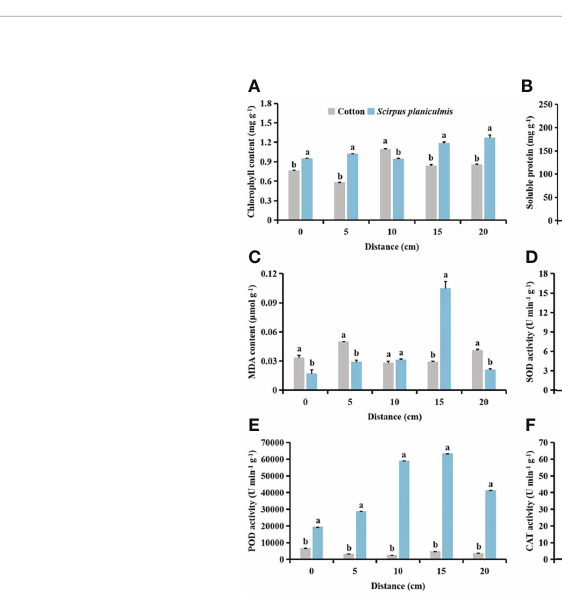
FIGURE 12 Effects of cotton and Scirpus planiculmis on (A) chlorophyll, (B) soluble protein and (C) malondialdehyde (MDA) content, and (D) superoxide dismutase (SOD), (E) peroxidase (POD) and (F) catalase (CAT) activities at different spatial distribution distances of S. planiculmis after spraying 0.015 g L -1 75% tri fl oxysulfuron + 4 g L -1 40% prometryn. The mean value ± standard data were presented in the fi gure. Different alphabetical letters indicate the signi fi cant differences between cotton and S. planiculmis ( p